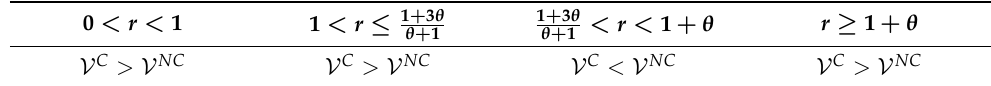
Table 2. Comparison of NVI for θ >